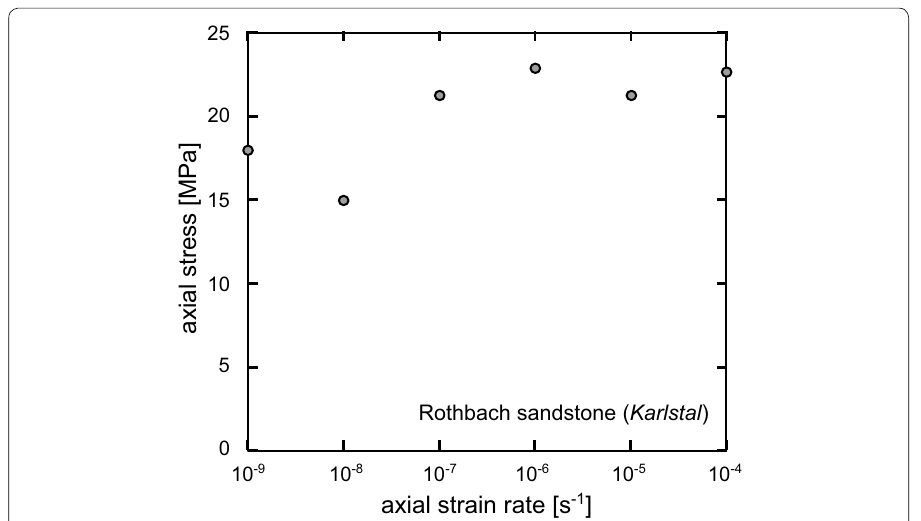
Fig. 9 Uniaxial compressive strength of water-saturated Rothbach sandstone as a function of axial strain rate (data given in Table 7)